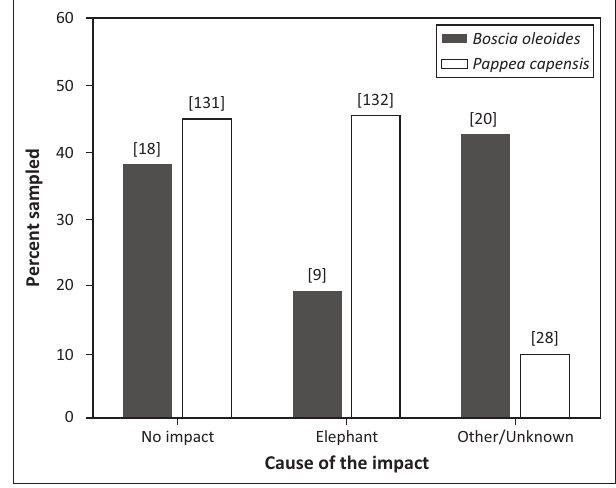
FIGURE 2: Relative impact of elephant on woody trees in the Kuzuko section. Numbers in brackets indicate the number of individuals of each species recorded.